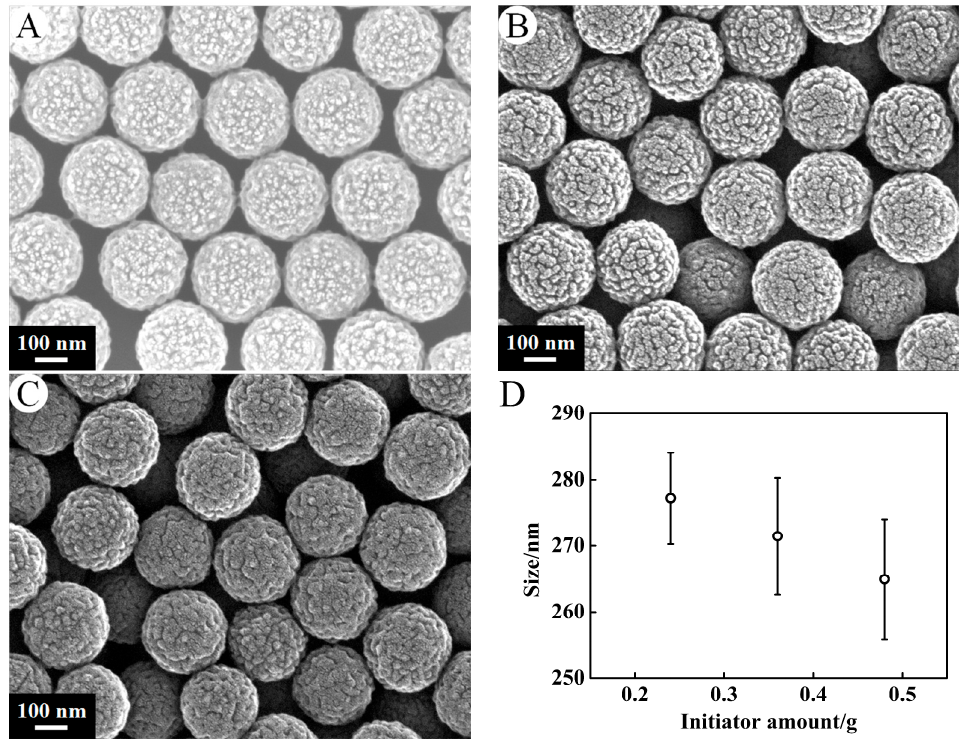
Figure 4. SEM micrographs of PSA nanospheres under preparation conditions of the initiator amount ( A ) 0.24 g, ( B ) 0.36 g, ( C ) 0.48 g. Other conditions: AA, 0.3 g; St, 6 g; stirrer speed, 300 r·min − 1 . Effects of initiator content on the size of the PSA nanospheres ( D ).